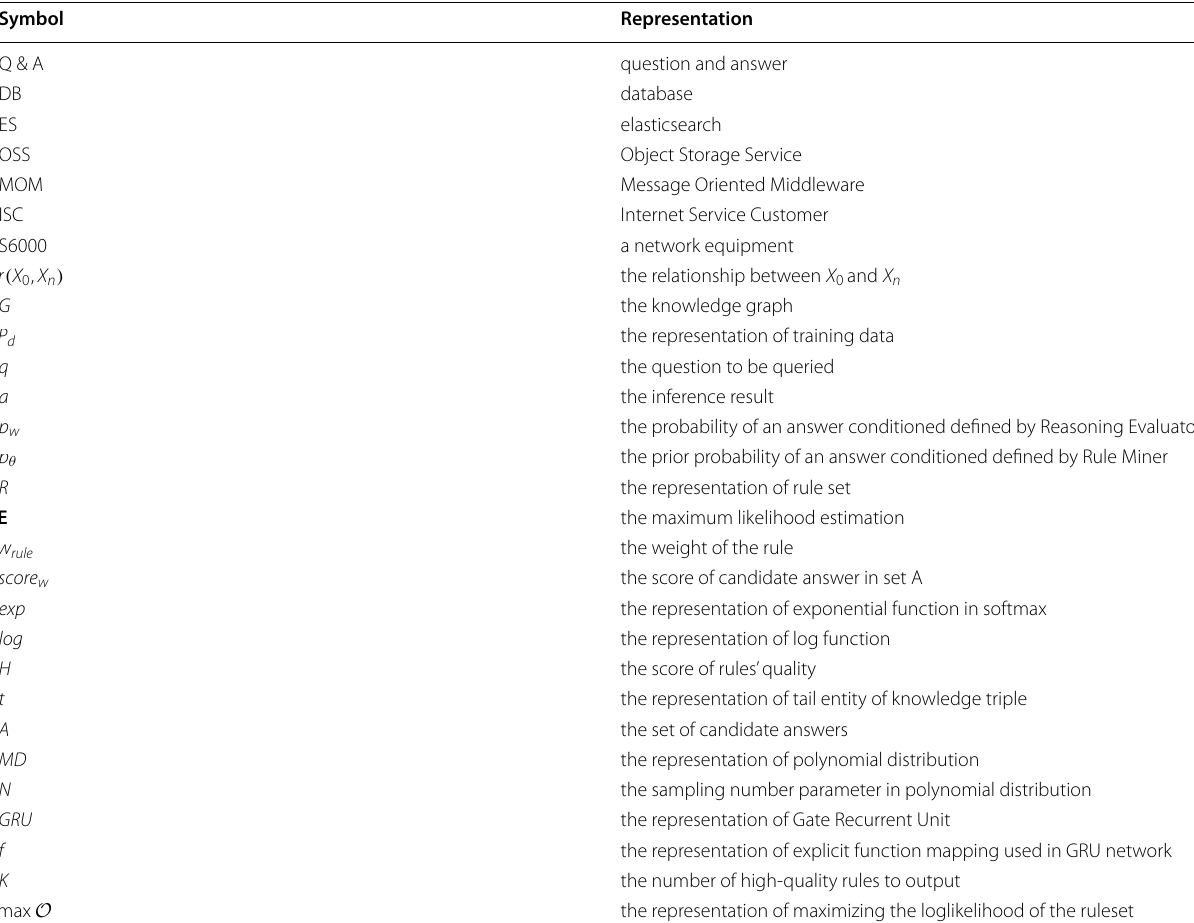
Table 1 Symbols and their representations in the proposed approaches